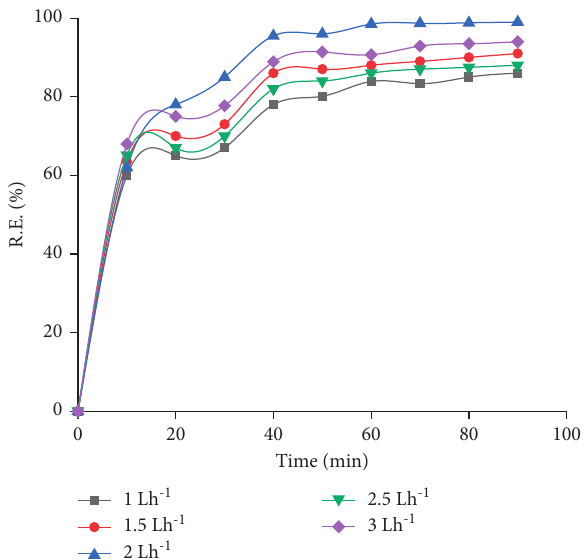
Figure 4: Influence of the flow rate on removal efficiency with electrolysis time.